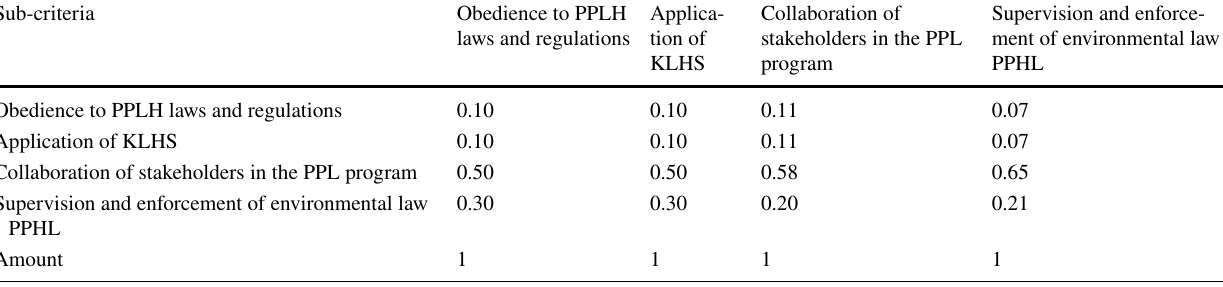
Table 15 Normalization sub-criteria comparison matrix Sub-criteria